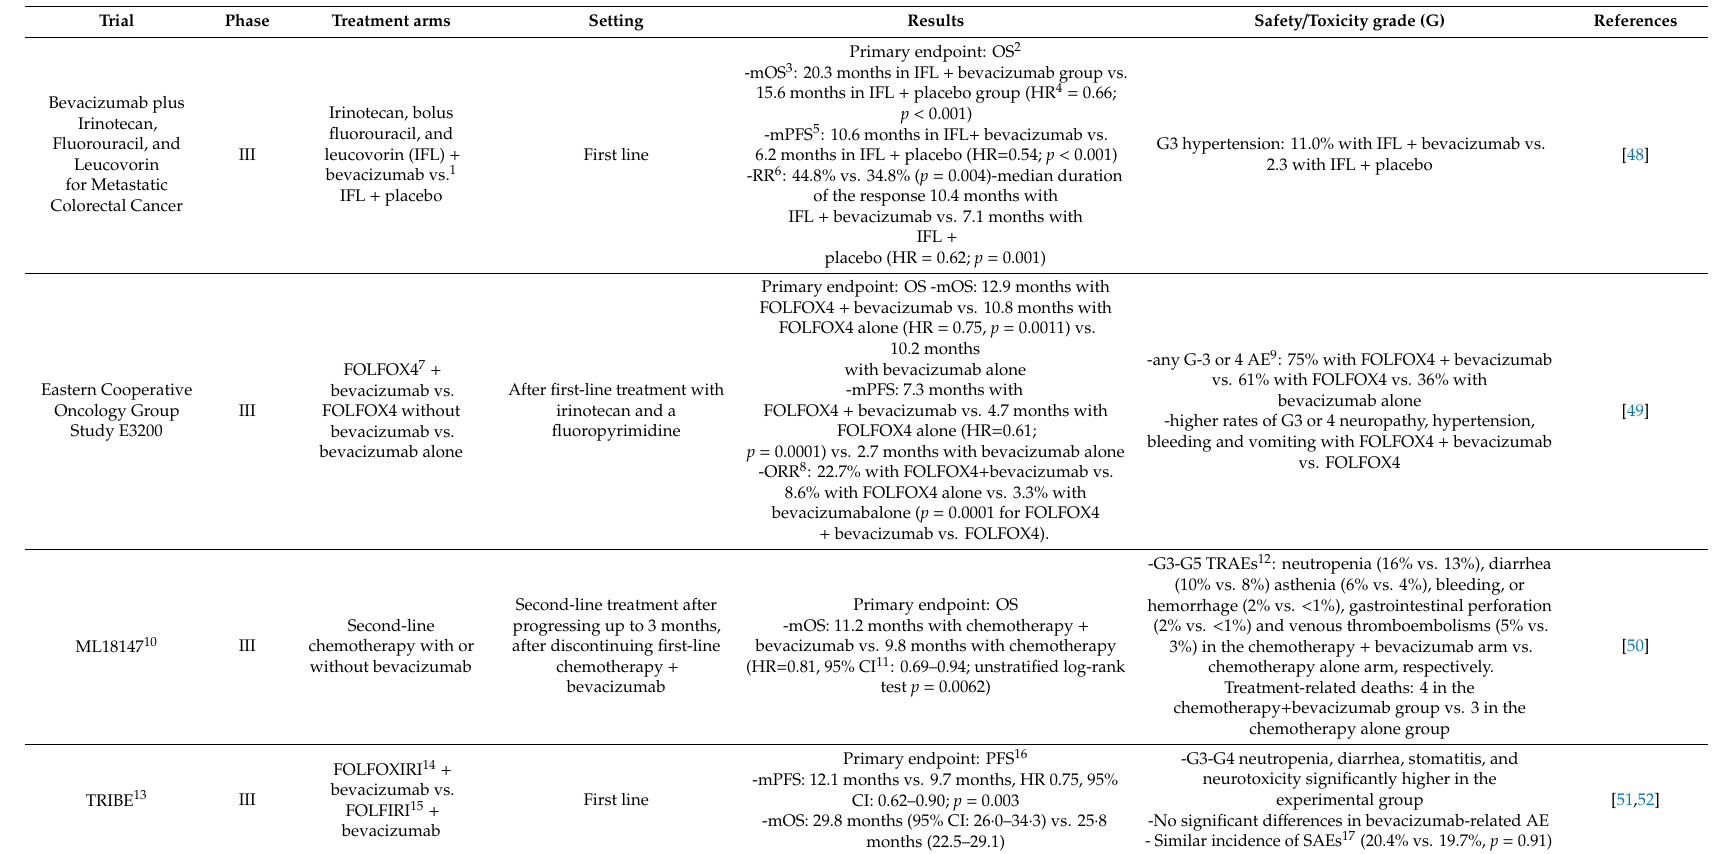
Table 3. Bevacizumab